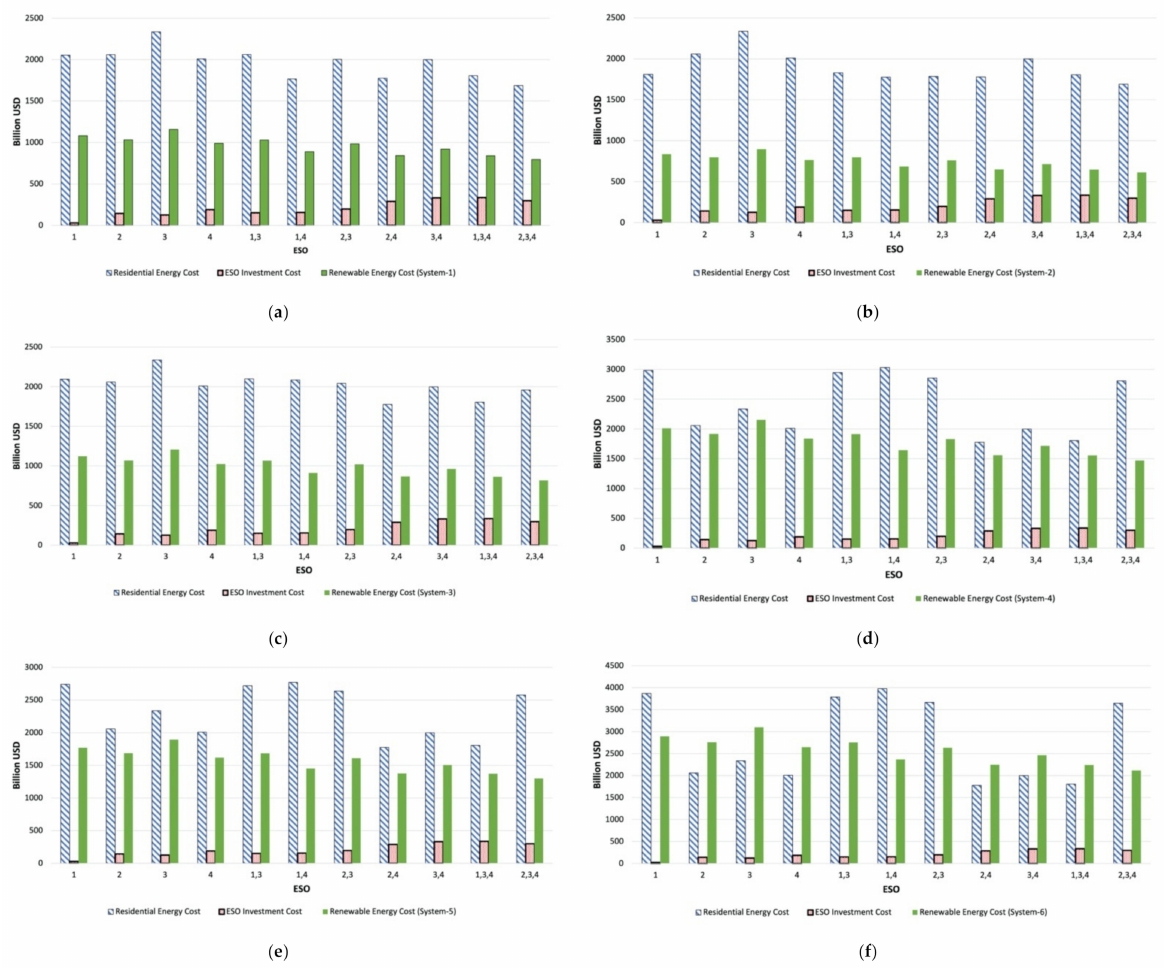
Figure 13. Cost of the system (1, 2, 3, 4, 5, and 6) as present ( a – f ) of clean energy in the residential building sector in Saudi